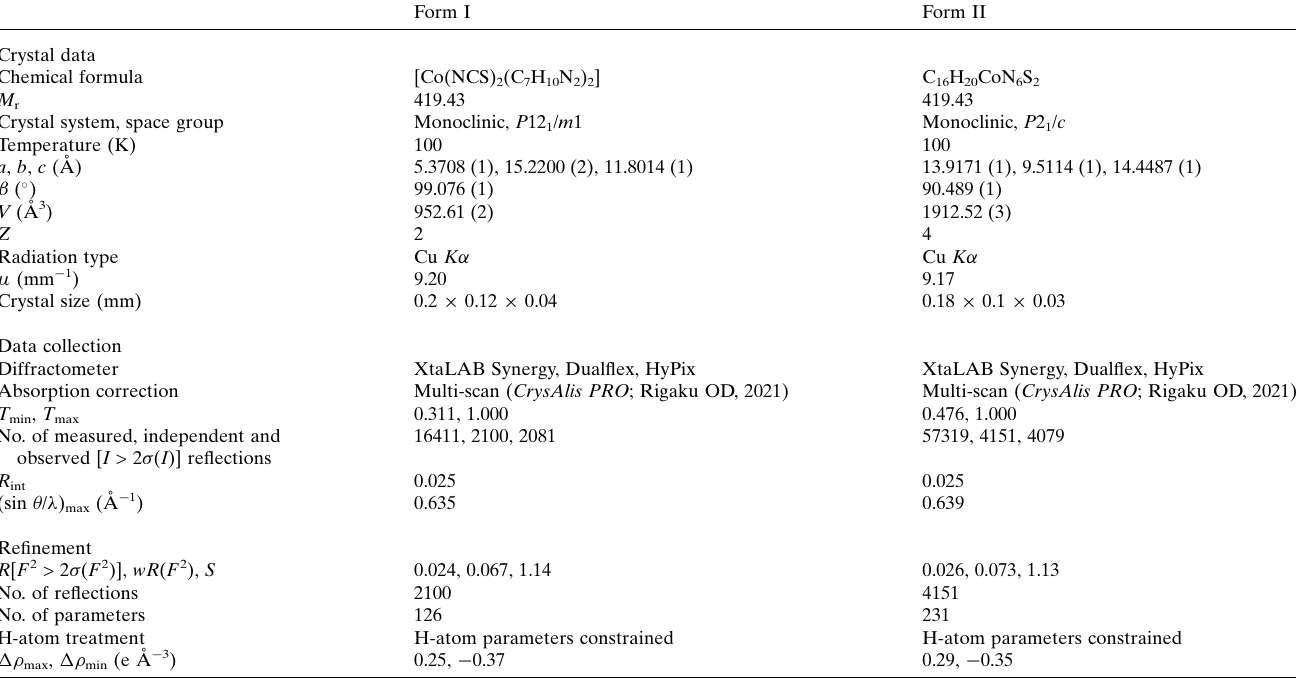
Table 5 Experimental details.